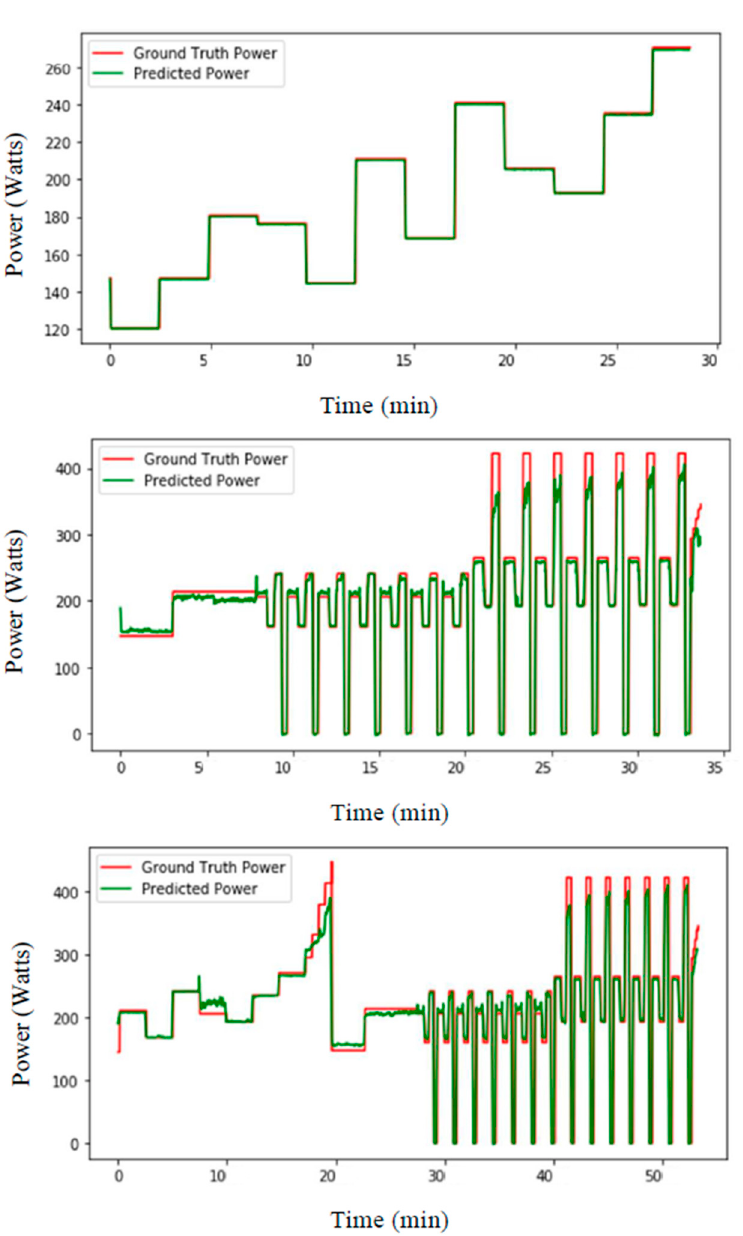
Figure 7. LSTM-based prediction of ski power (watts) from the data of ( top ) first, ( middle ) second and ( bottom ) both day(s) from subject 13 with training data of that day(s) from other subjects.